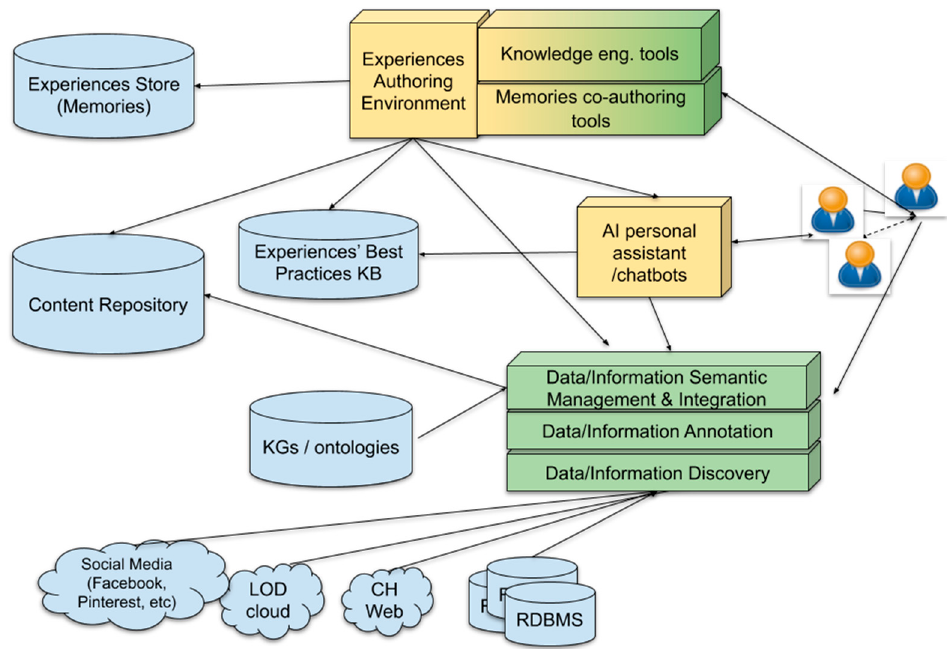
Figure 1. Proposed platform architecture, integrating Knowledge Graphs (KGs), Linked Open Data (LOD), data in the Cultural Heritage (CH) Web, and data available in Relational Database Management systems (RDBMS), supported by knowledge (best practices) provided in a knowledge base (KB)